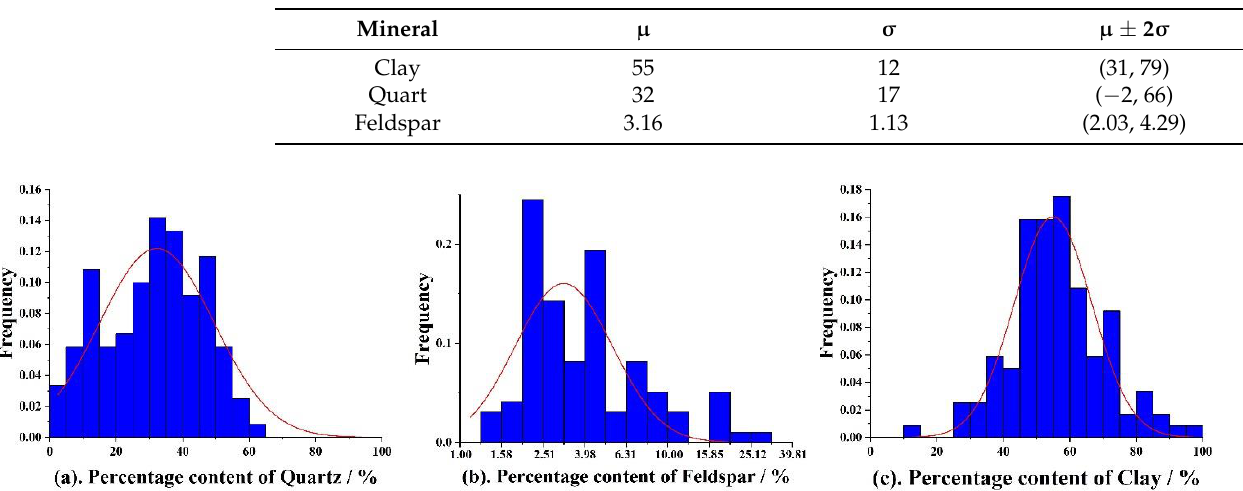
Table 1. Gaussian parameter values of mineral distribution.